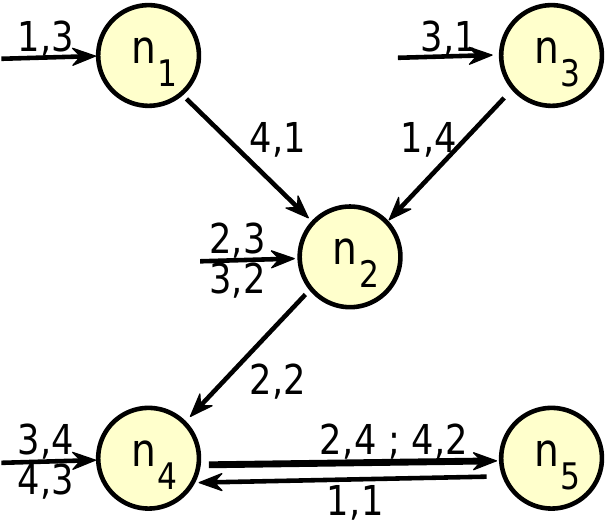
Figure 4. The neighbor graph of Figure 3 has a very simple structure.